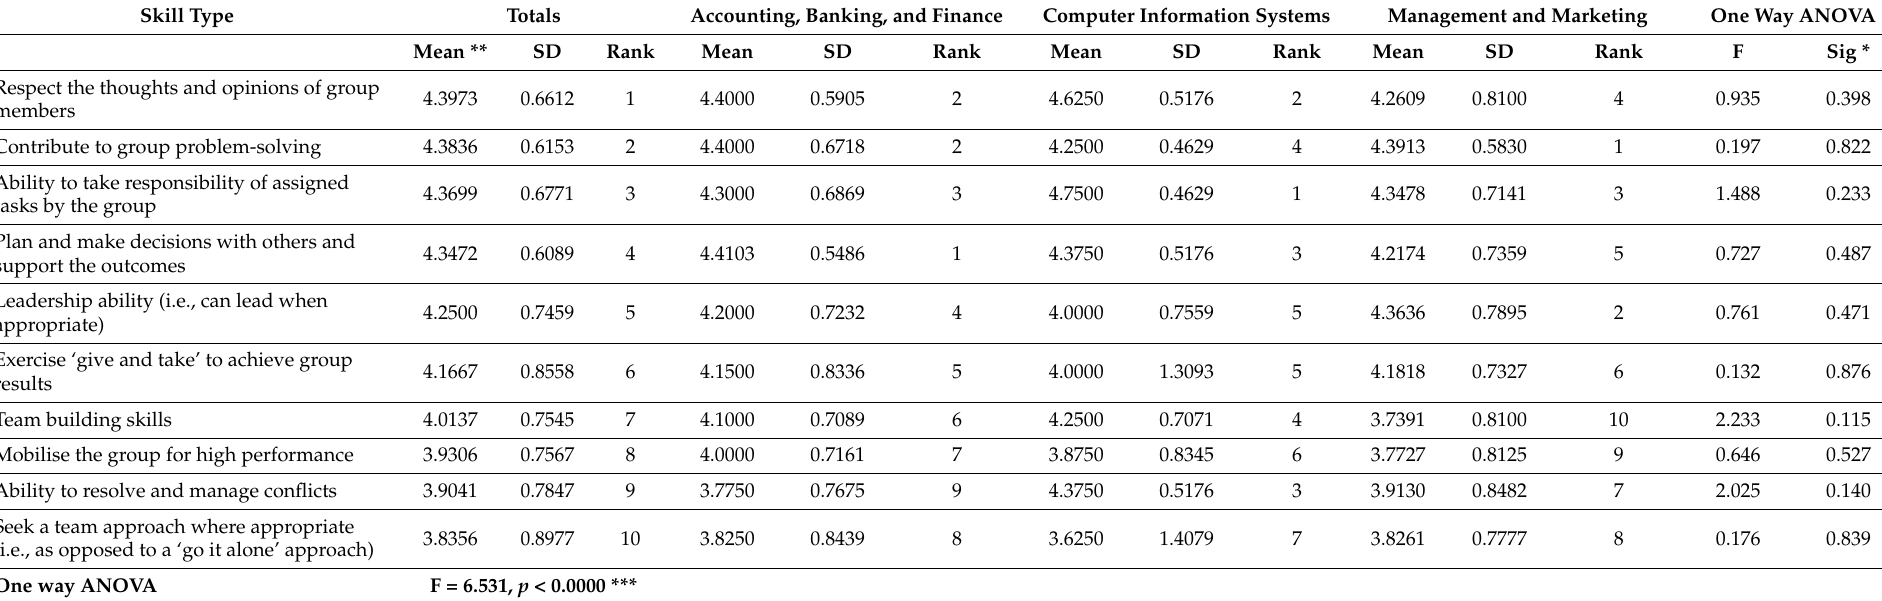
Table 6. Teamwork